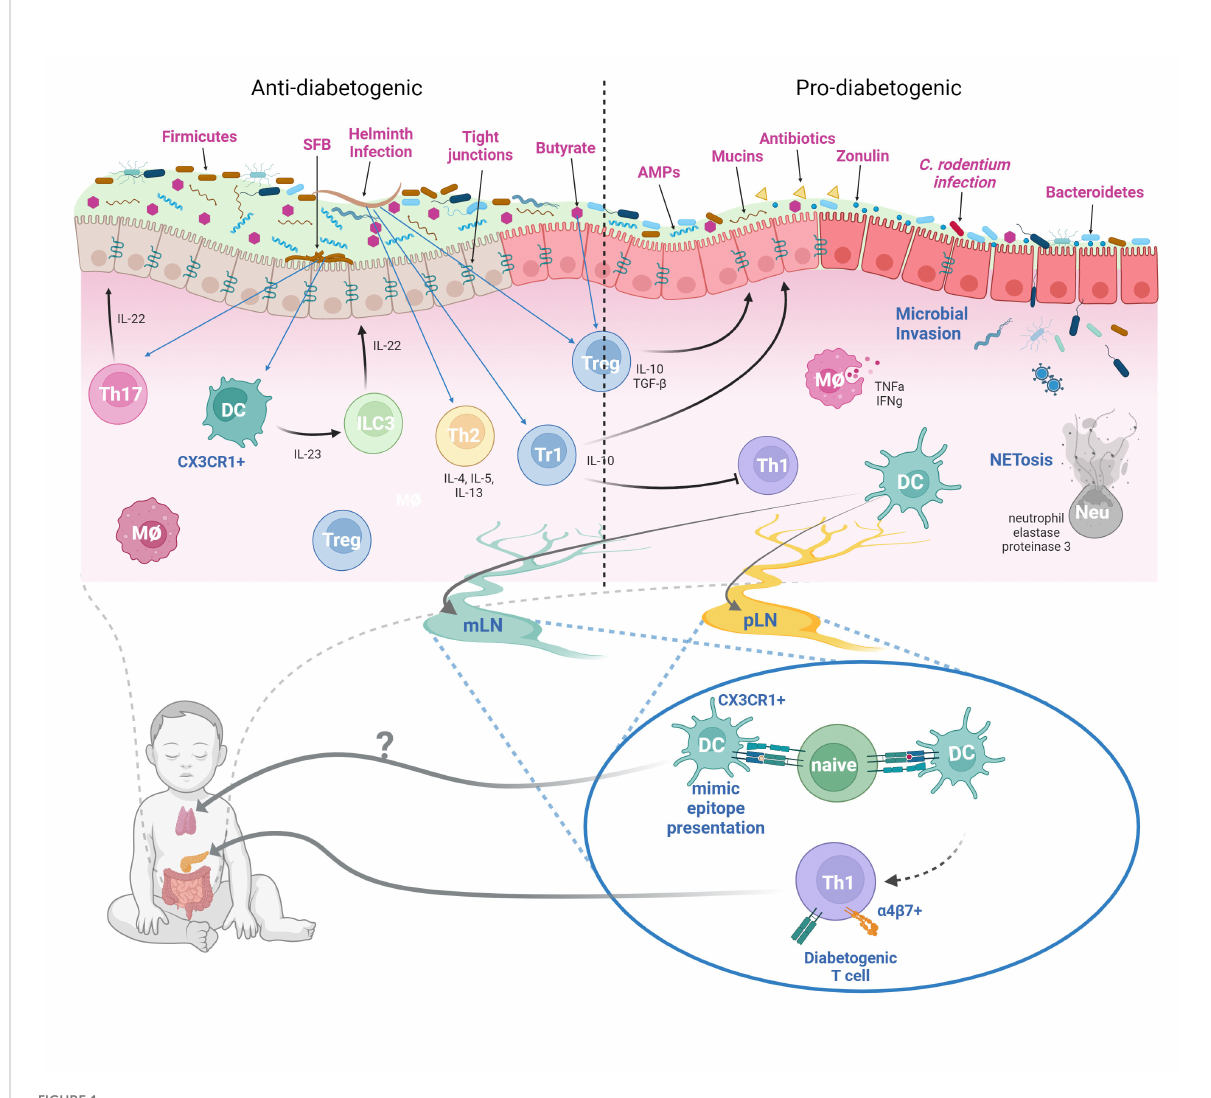
FIGURE 1 Dysbiosis, Compromised Gut Barrier, and T1D Risk. In a healthy gut microenvironment, most microbial species are not in direct contact with the epithelial barrier. The mucus layer serves as a barrier between the commensal microbes and the epithelium. Contained within the mucus layer are various innate immune components such as the antimicrobial peptides (AMPs) such as defensins, cathelicidins, and RegIII g . The adaptive immune system also supplies the mucus layer with IgA antibodies that bind to commensal microbes and prevent their adherence to the epithelium. However, certain commensals such as the SFB can directly adhere to the epithelium and stimulate Th17 response. SFB-induced immunity appears to protect NOD mice from autoimmune diabetes through enhancing intestinal barrier conferred by Type 3 immune cytokine IL-22. A high proportion of Firmicutes to Bacteroidetes ratio seems to protect against T1D presumably due to Firmicutes being a major butyrate producer. The SCFA butyrate can improve barrier integrity by enhancing barrier function of tight junctions, improve mucin production, and induction of intestinal Tregs. Helminth infections, which are more common prior to the improved hygienic practices in the past century, may also decrease T1D incidence through the induction of a type 2 response and the generation of regulatory Foxp3+ and Tr1 cells. In dysbiosis, altered Firmicute/Bacteroidetes ratio may diminish SCFA production, reducing intestinal barrier function, and promote leaky gut syndrome. Infections by certain microbes such as C. rodentium can also enhance gut permeability. Additionally, antibiotic usage can also reduce commensal diversity and lead to dysbiosis. The resulting depletion of the mucus layer and the compromised tight junction may allow in fi ltration of microbes through the epithelium and induce innate immune cell activation. Production of in fl ammatory cytokines by innate cells and NETs by neutrophils further exacerbates gut permeability. The in fl ammatory gut environment promotes the activation of diabetogenic T cells in the mLN and the pLN, which then traf fi c to the pancreas and cause islet damage. Furthermore, b -cell antigen mimics found in the gut microbes and enteric pathogens can also potentially activate diabetogenic T cells and contribute to disease. Whether these mimics can be traf fi cked to the thymus to mediate T cell central tolerance is unclear ( fi gure created with